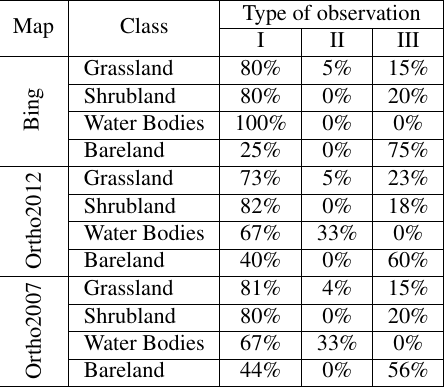
Table 9. Percentage of correctly classified points with respect to